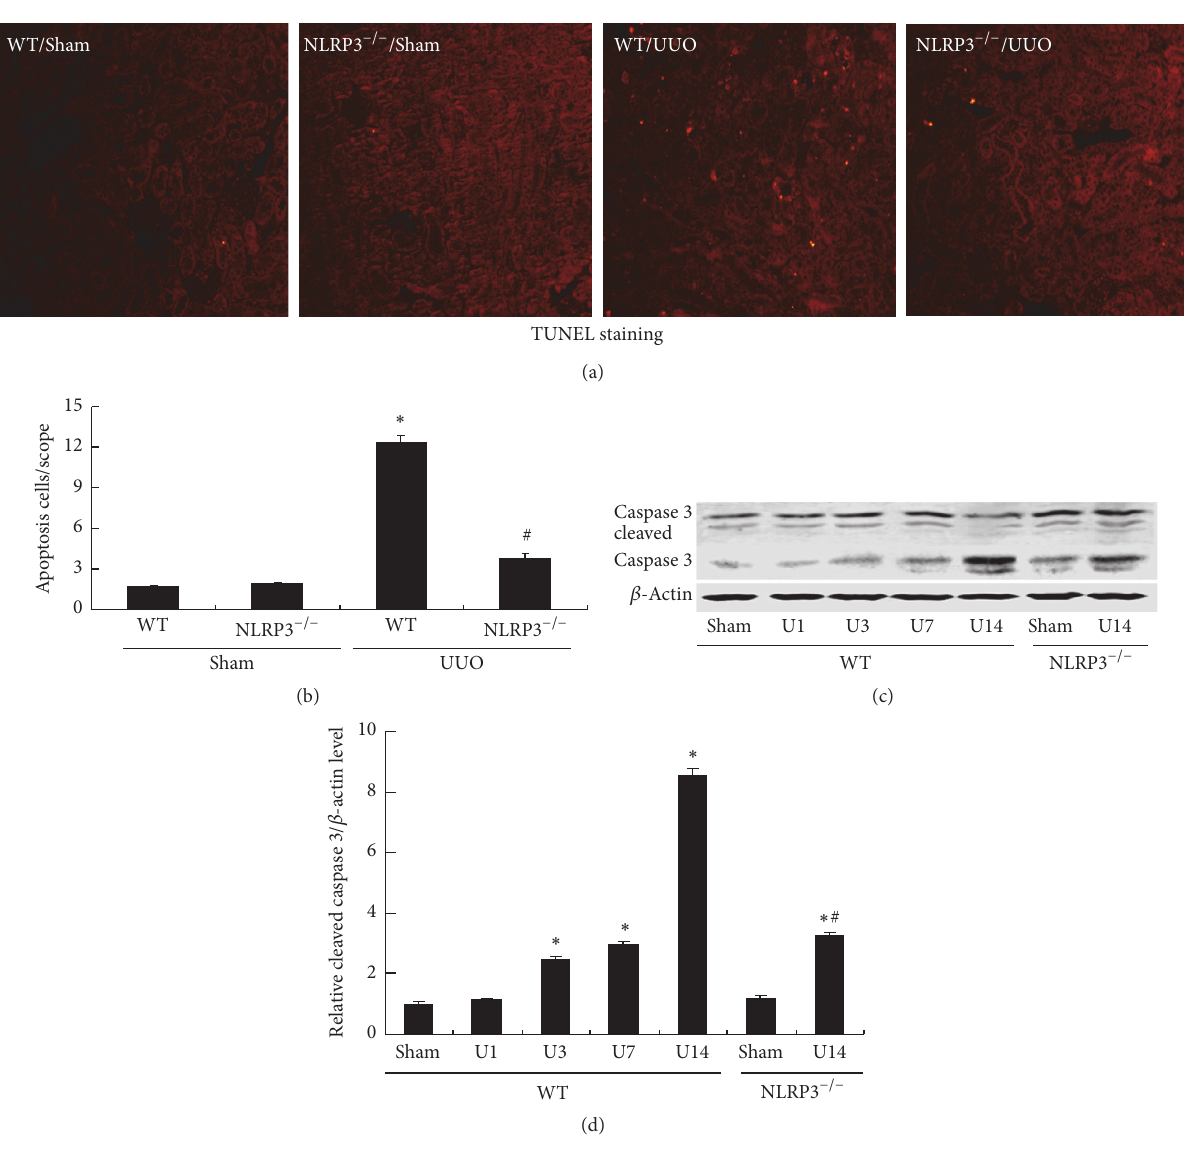
Figure 5: NLRP3 deletion ameliorates UUO-induced cell apoptosis in UUO mice. Representative images of TUNEL staining are shown ((a), magnification, × 200). Bar graph indicates the mean number of TUNEL-positive tubular cells per field (b). Expression of caspase 3 protein was detected in kidney samples (c). Semiquantitative analysis of cleaved caspase 3 normalized against 𝛽 -actin (d). Data represent the mean ± SEM ( 𝑛 = 6 ). ∗ 𝑃 < 0.05 , compared with WT/Sham group, # 𝑃 < 0.05 , NLRP3 −/− /U14 group versus WT/U14 group. U1, U3, U7, and U14 indicate that mice were sacrificed on days 1, 3, 7, and 14 after